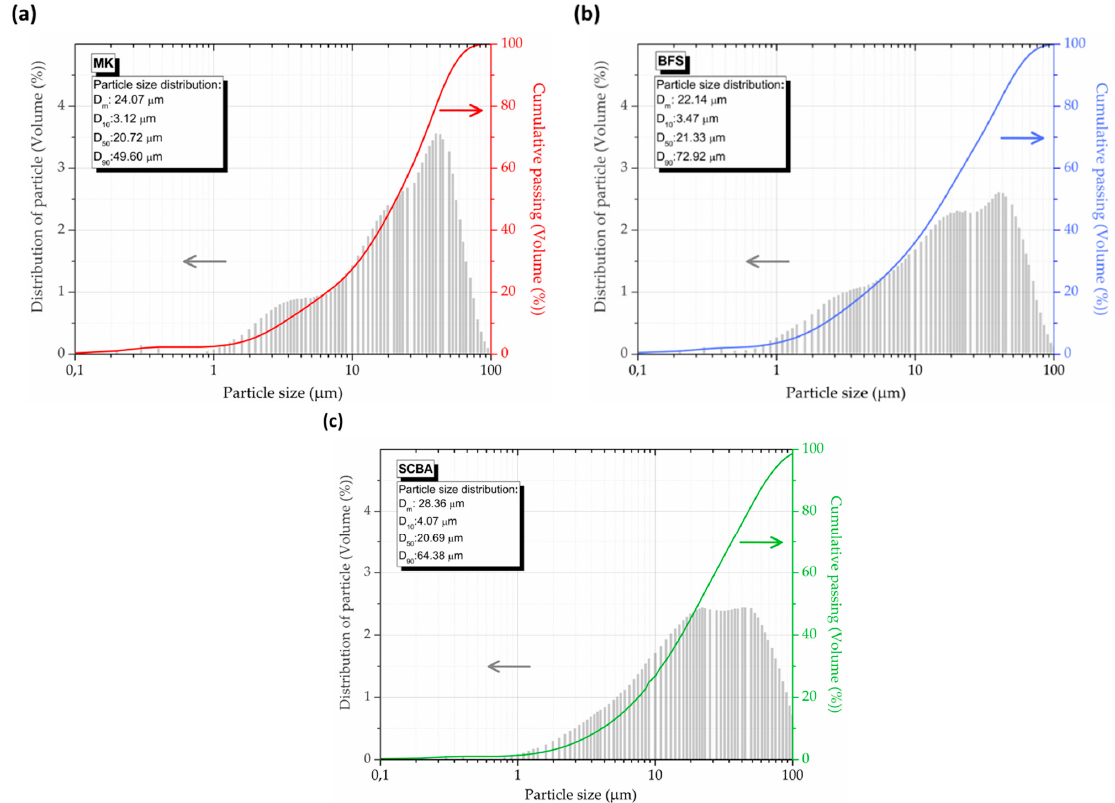
Figure 10. Particle size distribution of the precursors: ( a ) MK, ( b ) BFS and ( c ) SCBA. The chemical oxides in SCBA, MK and BFS (Table 2) were identified by X ‐ Ray fluo ‐ rescence (XRF) Shimadzu equipment (Tokyo, Japan). The loss on ignition (LOI) value of 11.5% is similar to other research studies that reported values more than 10% for SCBA without further treatment [12,22,26]. Table 2. Chemical composition of precursors metakaolin (MK), slag (BFS) and sugarcane bagasse ash (SCBA) (mass%). SiO 2